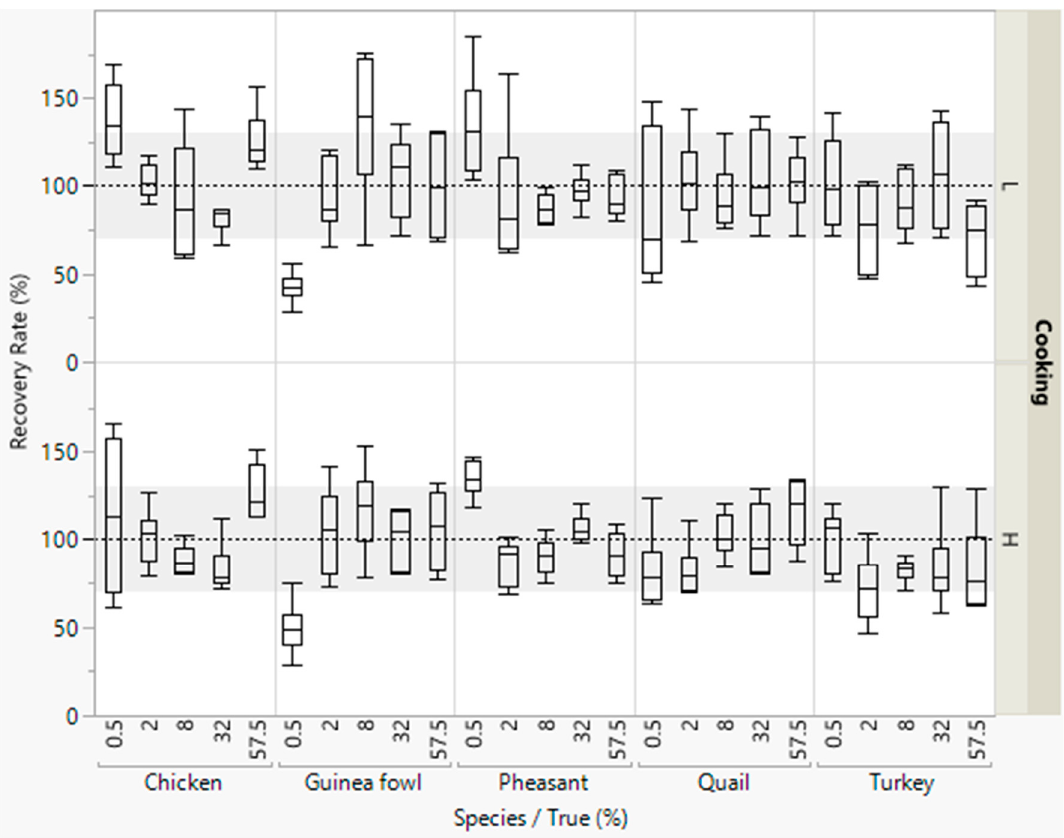
Figure 3. Recovery rates of meat from five poultry species in emulsified type sausages (with 0.5–57.5% meat) quantified with an internal reference sequence. All concentration levels were cooked at low (L) or high temperature (H). DNA was isolated in duplicate from each sausage from both batches, and three independent real-time PCRs were performed, i.e., box plots are from twelve measurements. The grey areas represent the accepted range of 70–130%.